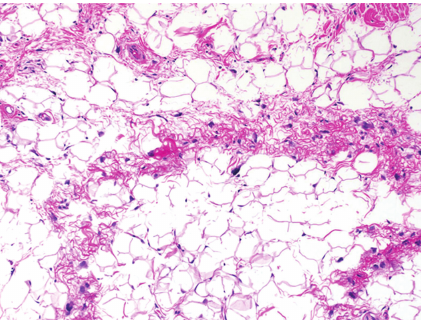
F 1: Histologic presentation of atypical lipoma. Atypical lipoma composed of mature fat and �brous tissue with scattered, enlarged, hyperchromatic